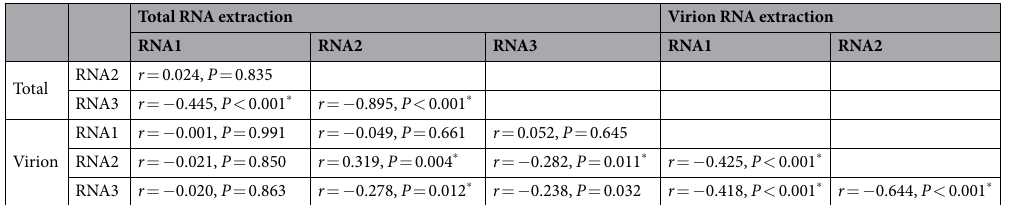
(from Fig. 1C). The dashed line represents the expectation under the null hypothesis of no-FDS 32 . For each RNA, we computed the output and input log-relative abundance and plotted them (different symbols). First, the data were fitted to a set of models with increasing number of parameters, but in all cases the linear regression was the best-fitting model (shown as solid lines). In all three cases, statistical significance of the FDS is tested by the devi- ation of the slope of the linear regression from 1 (the dashed diagonal). All three regression lines in Fig. 2A have